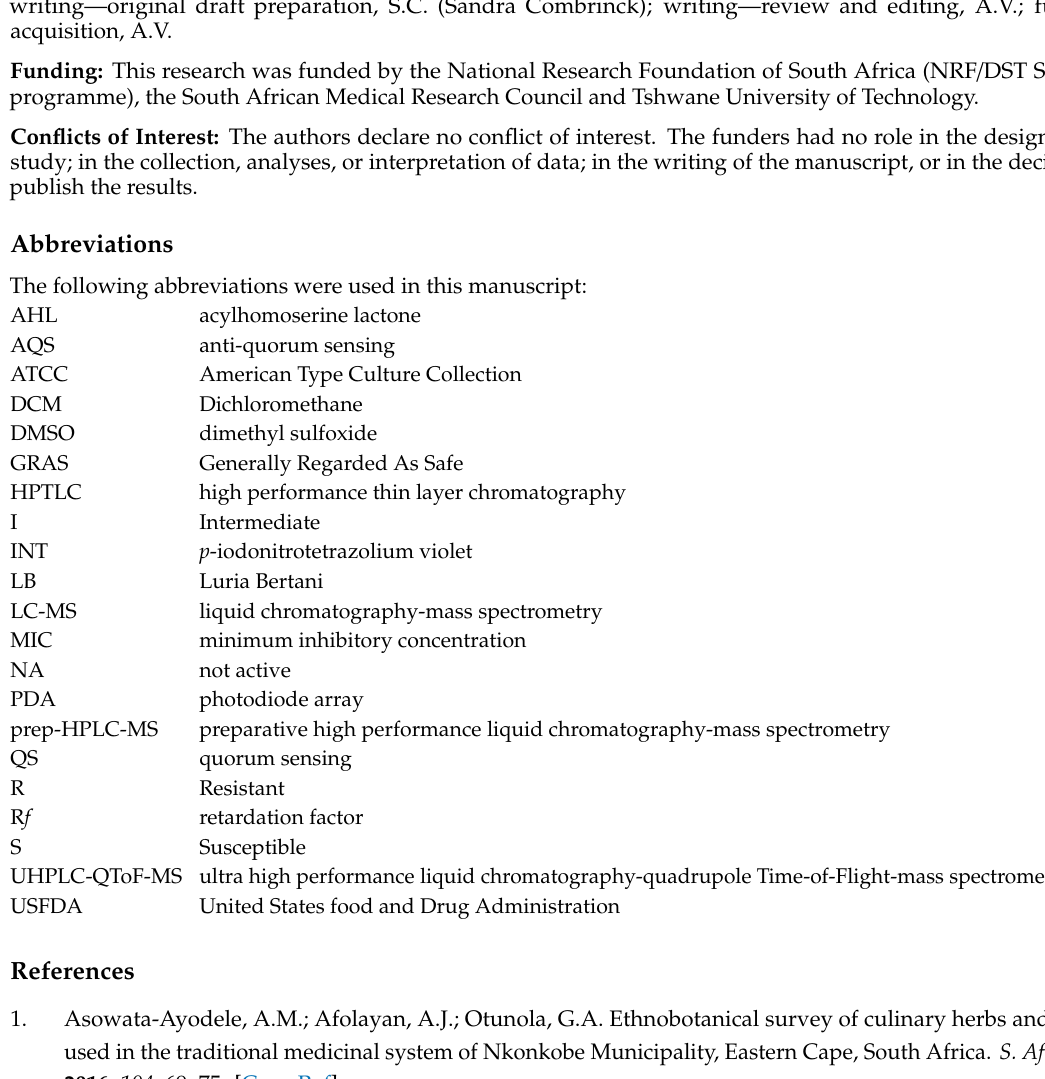
Table S1: Quantification of quorum sensing inhibitory e ff ect of di ff erent plant extracts on violacein production at di ff erent concentrations (0.350–7.00 mg / mL), Figure S1: Representation of the agar well di ff usion assay used to screen various plant extracts against Chromobacterium violaceum ATCC